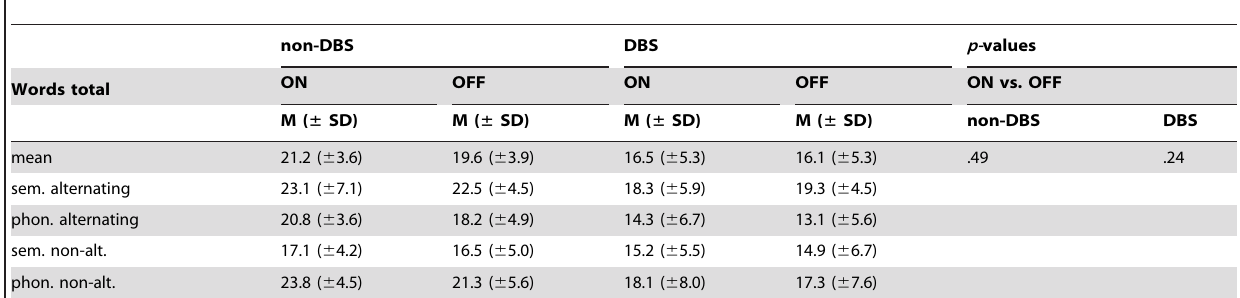
Table 3. Verbal Fluency